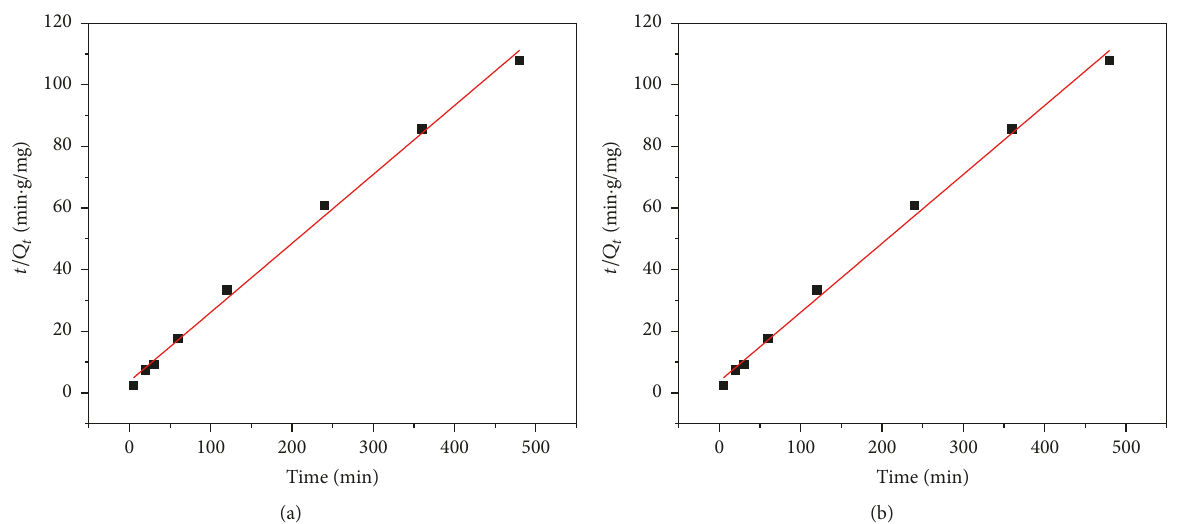
Figure 11: Adsorption kinetic for selenium removal: (a) pseudo-first-order and (b) pseudo-second-order model (agitation speed = 150rpm, pH = 6, CNTs dosage = 10 mg, and initial concentration = 1ppm).